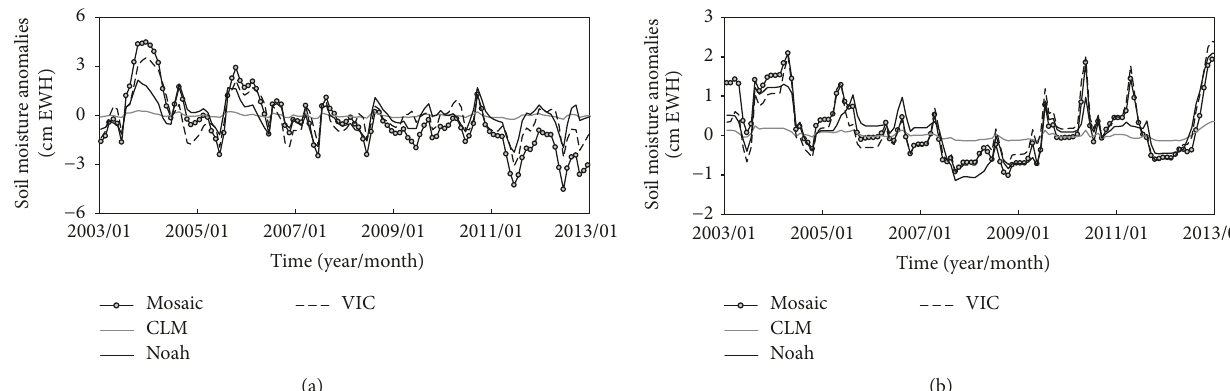
Figure 11: Monthly temporal variations of soil moisture of four LSMs in GLDAS in (a) the Huang-Huai-Hai Plain and (b) the Song-Liao Plain.